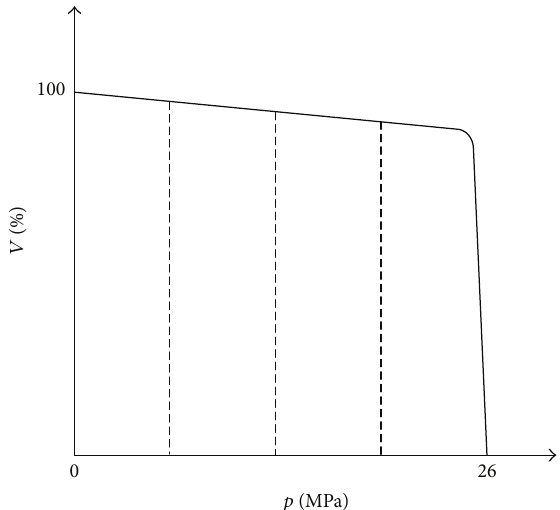
Figure 9: Relationship between pressure and setting displacement of main pump.